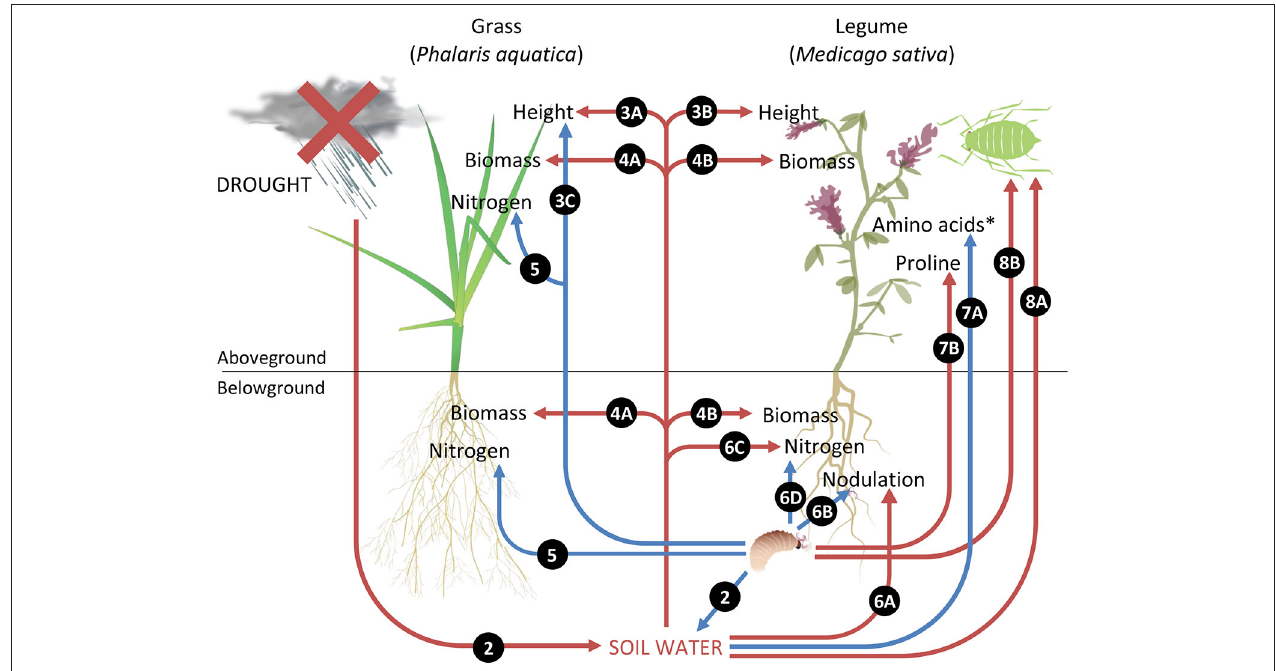
FIGURE 9 | Summary of key results illustrating plant–herbivore interactions under drought. Red arrows indicate negative impacts and blue arrows represent positive impacts. Numbers refer to relevant figures associated with each effect. * Amino acids represent concentrations of groups one and three amino acids, namely glycine, lysine, methionine, tyrosine, cysteine, histidine, arginine, aspartate, and